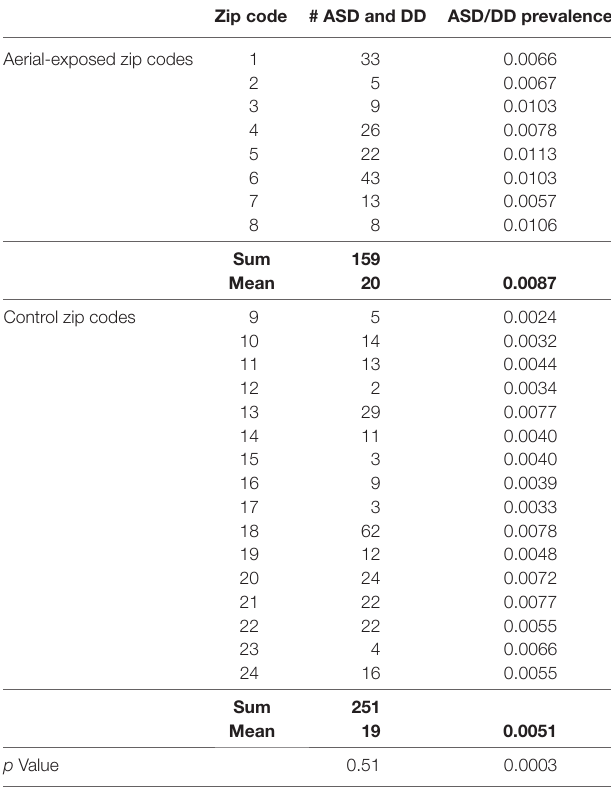
TaBle 4 | Prevalence of autism spectrum disorder (asD) or developmental delay (DD) diagnosis at the regional medical center for children from aerial-exposed and control zip